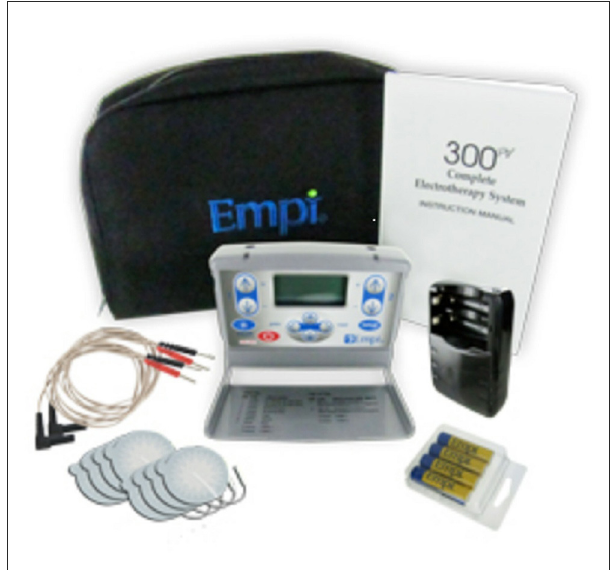
FIGURE2 TENS, NMES (Empi 300PV unit).